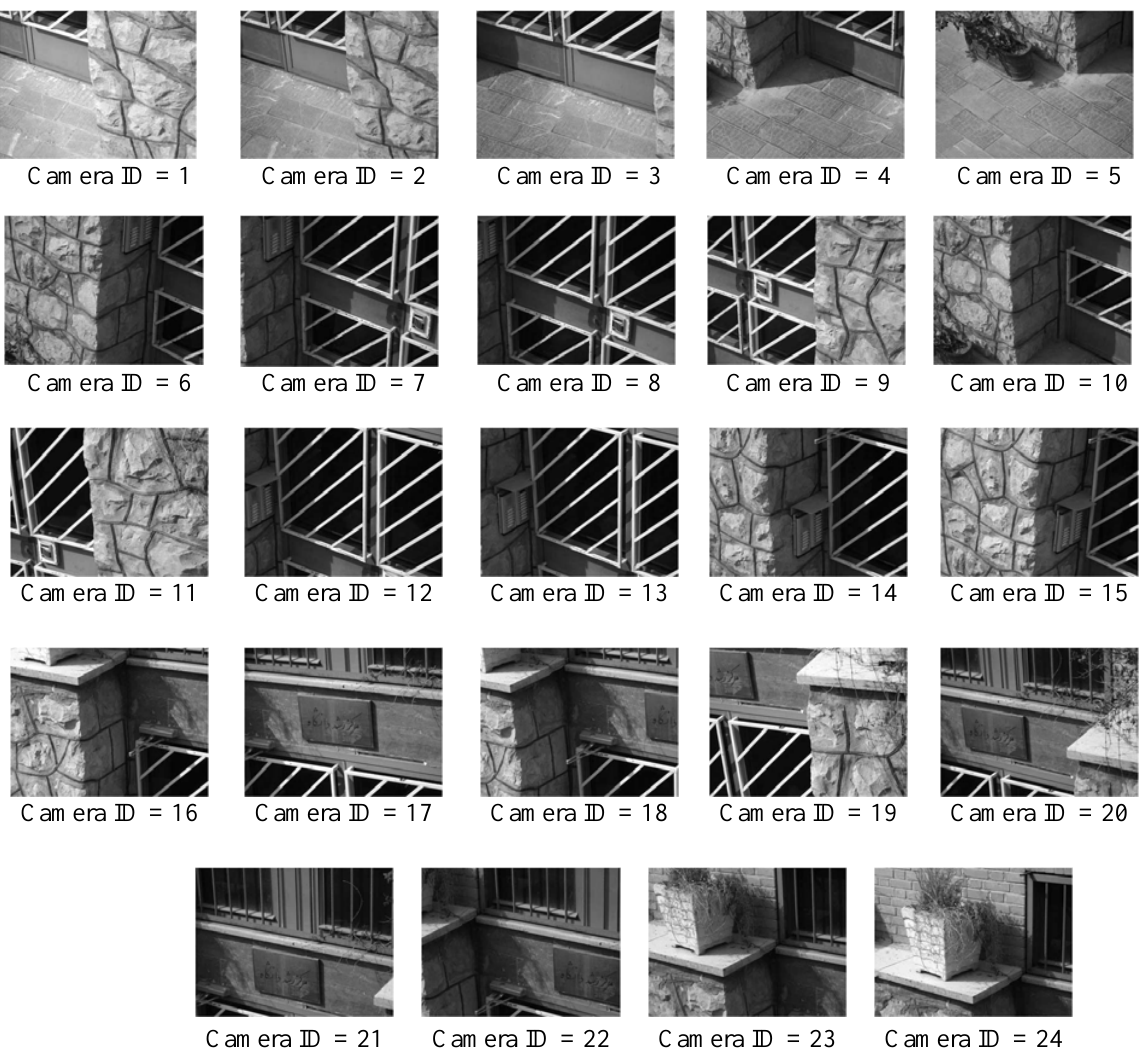
Figure 7. Assumed Camera Sensor Node Gray-Scale Images with Resolutions 320 × 240 Managed by Specific Cluster Head in